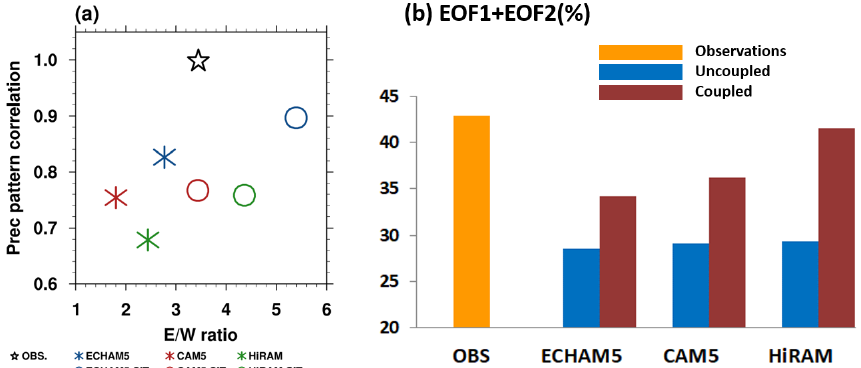
Figure 7. Scatter plots of various MJO indices based on observations and experiments (Table 1). (a) The x axis is the power ratio of east– west-propagating waves. The east–west ratio was calculated by dividing the sum of eastward-propagating power by its westward-propagating counterpart within wavenumbers 1–3 (1–2 for zonal wind) and a period of 30–80d. The y axis is the pattern correlation of precipitation and eastward propagation, as shown in Fig. 2. (b) Sum of RMM1 and RMM2 variances based on Wheeler and Hendon